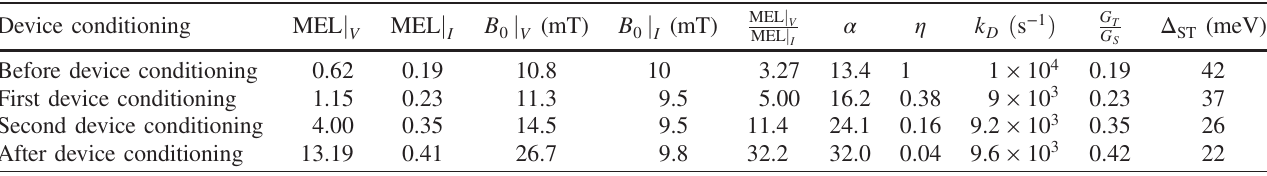
TABLE I. Effect of various device conditioning procedures on a square device 0.6 mm on a side (see Sec. III for details). The row number of the table signifies increasing conditioning times and/or currents. Specifically “ Before device conditioning ” is for zero conditioning time, “ First device conditioning ” is for 3 min conditioning at 0.1 mA, “ Second device conditioning ” refers to an additional conditioning of 10 min at 0.1 mA plus an additional 3 min at 0.2 mA, whereas “ After device conditioning ” signifies an additional conditioning for 15 min at 0.2 mA resulting in the optimally conditioned device. The first four columns contain directly measured quantities: MEL j (MEL j ) is the maximum MEL measured for a constant voltage (current), B 0 j V I maximum and is also the parameter entering into the non-Lorentzian empirical law. The next two columns show quantities that can be calculated from the measured data without reference to any theory: α is the exponent of the device ’ s nonlinear I − V characteristics (see Sec. VA) and η is the relative electroluminescence efficiency ( η ≡ 1 for the pristine device). The remaining quantities are extracted from fits to our theory (see